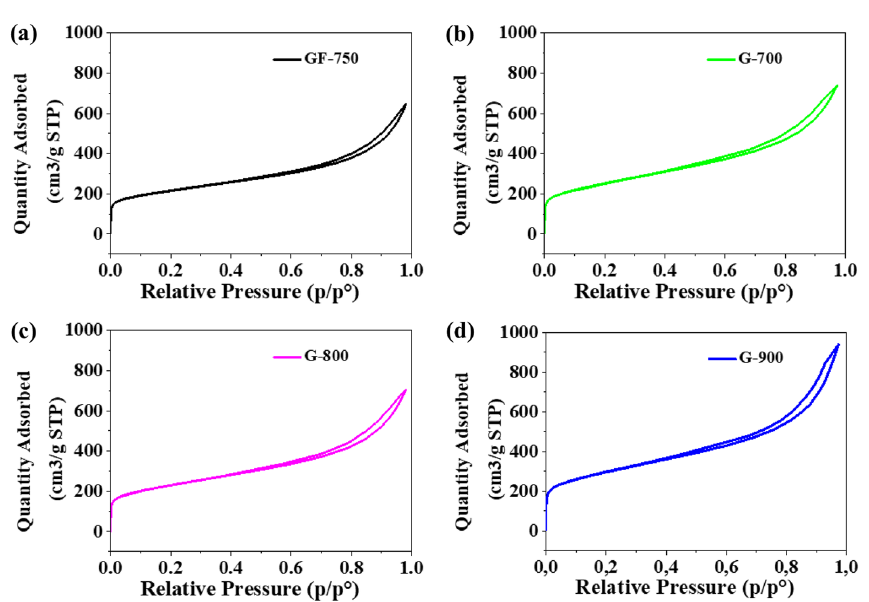
Figure 2. Nitrogen adsorption–desorption isotherms of samples ( a ) GF-750, ( b ) G-700, ( c ) G-800 and ( d )